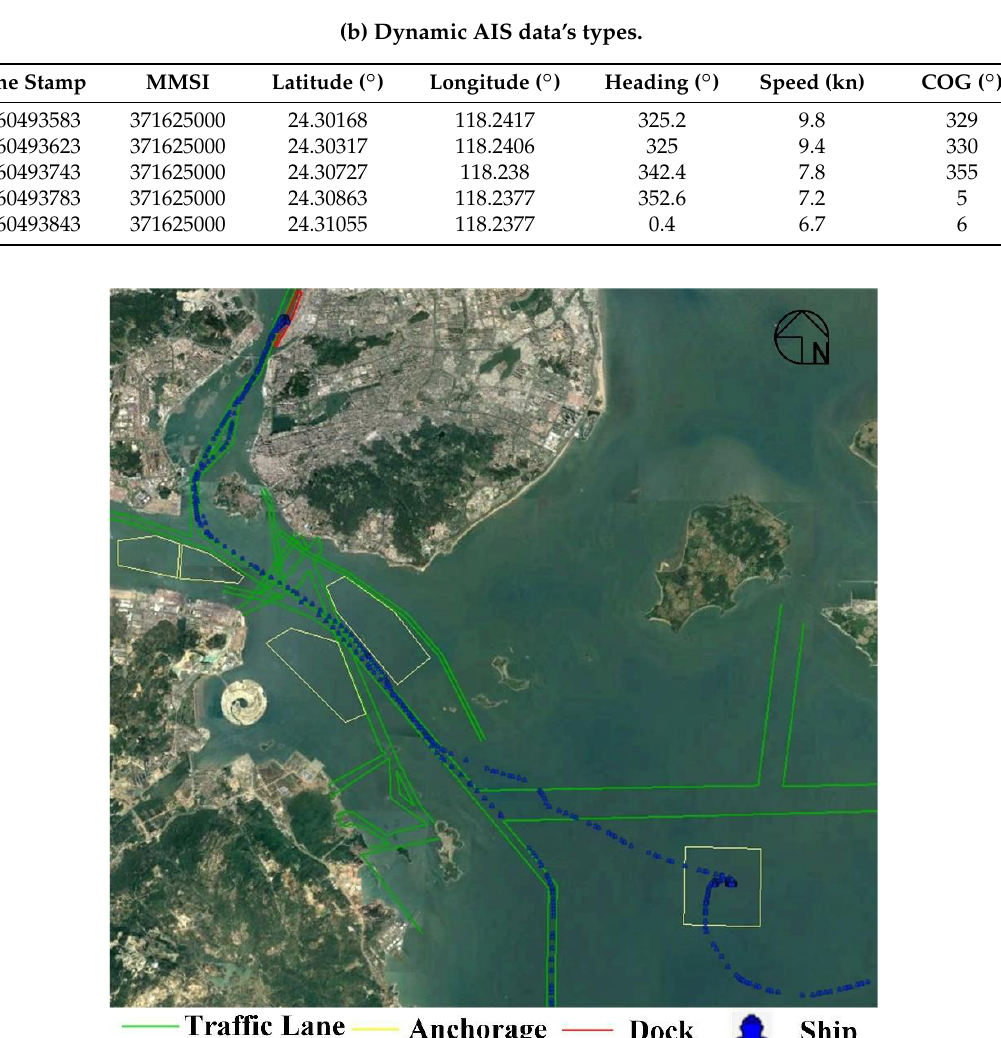
Figure 12. Trajectory of KUOTAI in Xiamen harbor. KUOTAI comes to Xiamen harbor from east, and